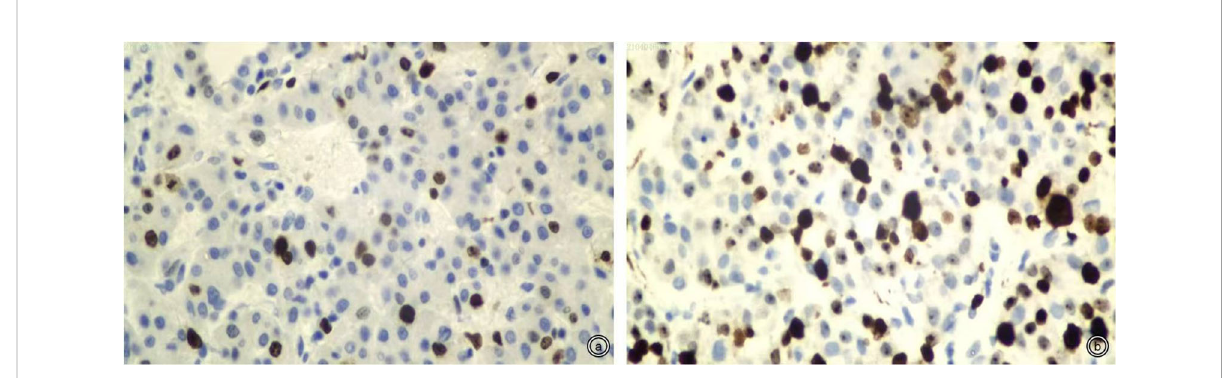
FIGURE 2 Representative staining patterns of Ki-67 (×400). (A, B) : Low and high Ki-67 expression (approximately 10% and 50%).